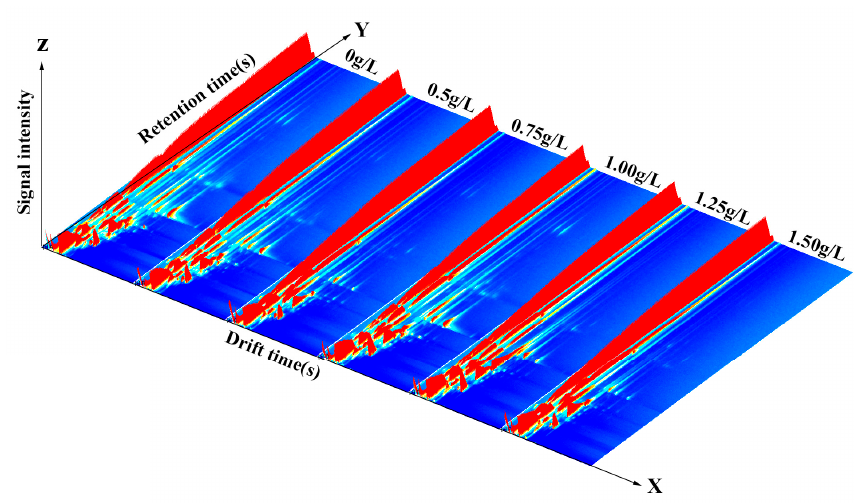
Figure 10. GC-IMS 3D spectra of crucian carp muscle after anaesthesia. From left to right: 0, 0.50, 0.75, 1.00, 1.25, and 1.50 g/L vanillin. The 2D top-view GC-IMS plots (Figure 11A,B) allow visual comparison of the volatile flavour profiles of carp muscle resulting from different vanillin treatment concentrations and significant differences between samples are visible. The GC retention time and IMS migration time of the volatile flavour compounds from carp muscle after treatment, with different concentrations of vanillin, were compared with the GC-IMS database on crucian carp muscle volatiles. The library search identified 40 flavour compounds (Figure 12, Table 4), including eight aldehydes, 11 alcohols, 10 ketones, two esters, and one furan.